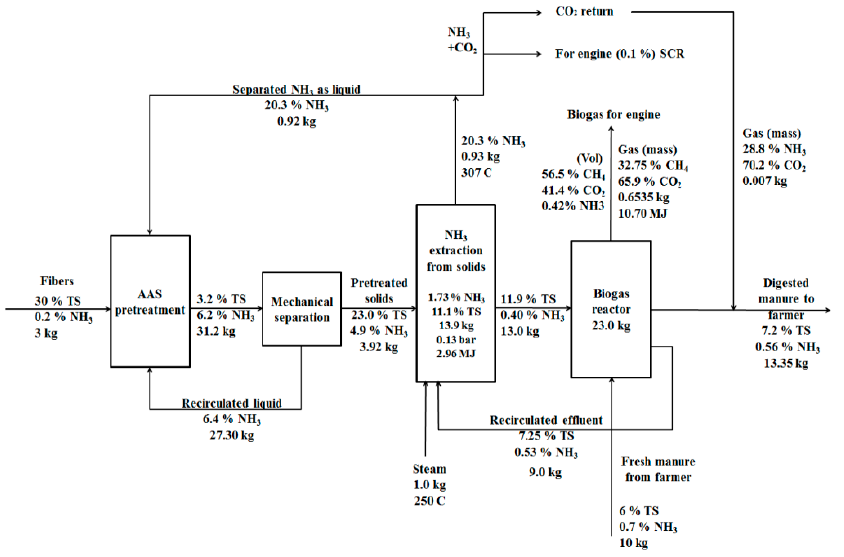
Figure 2. AD process of swine manure coupled with AAS pretreatment of manure fibers and NH 3 recovery. All mass and energy units are expressed per hour.